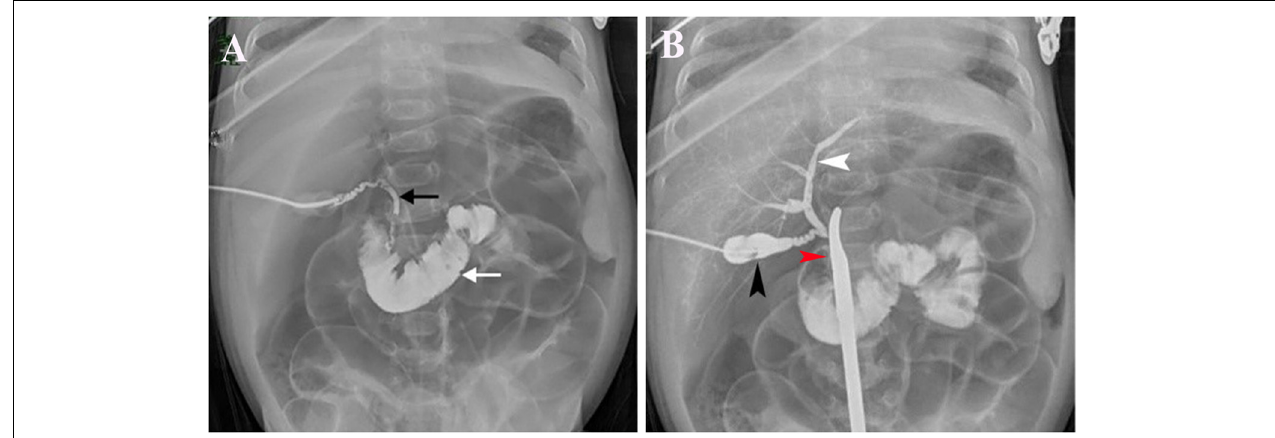
FIGURE 3 | LAC in a 51-day-old patient with cholelithiasis. (A) Contrast agents entered the duodenum (white arrow) and showed a discontinuous common bile duct (black arrow). (B) Contrast agents were injected from the gallbladder (black arrow) and had visible intrahepatic bile ducts (white arrow) when the inferior segment of the common bile duct was controlled with a forceps (red